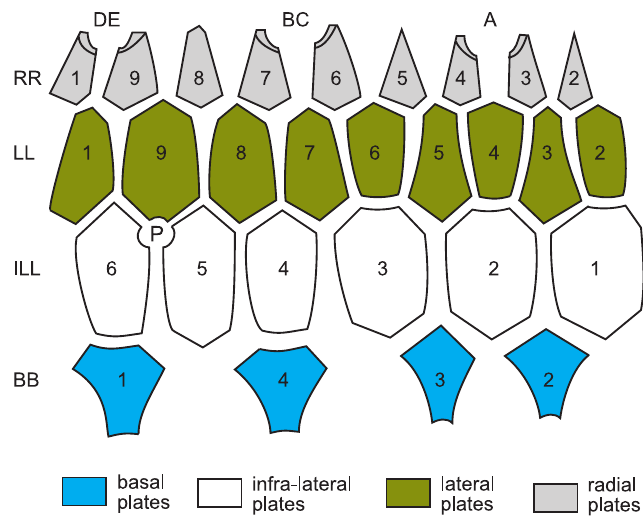
Fig. 10. Standard thecal plate diagram for the hemicosmitoid Hemi­ cosmites spp. The theca consists of four circlets, basals (B, BB), infra- laterals (ILL), laterals (LL), and radials (RR). In Hemicosmites spp. there are four BB, six ILL, nine LL and nine RR. Hemicosmites spp. have only three erect ambulacra (A, shared BC, and shared DE) on facets developed on plates R4:R5, R7:R8, and R1:R2, respectively. P, periproct (surrounding anus). Compare with Figs. 6G 2 and 9. For plate homologies see Table 2. Redrawn and relabelled from Bockelie 1979: 371, fig.